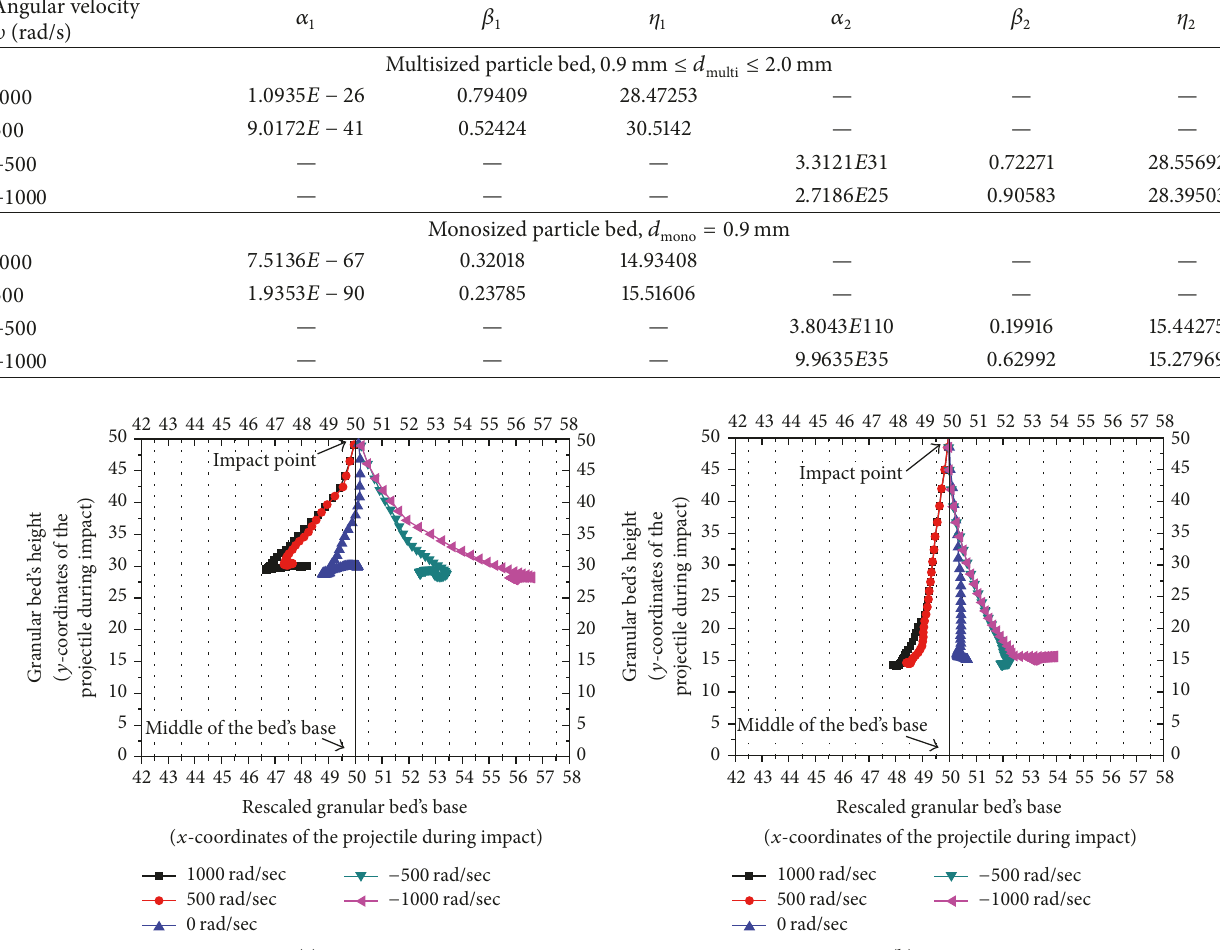
multisized and monosized particle beds during the interval time 𝑡 = [0, 10]